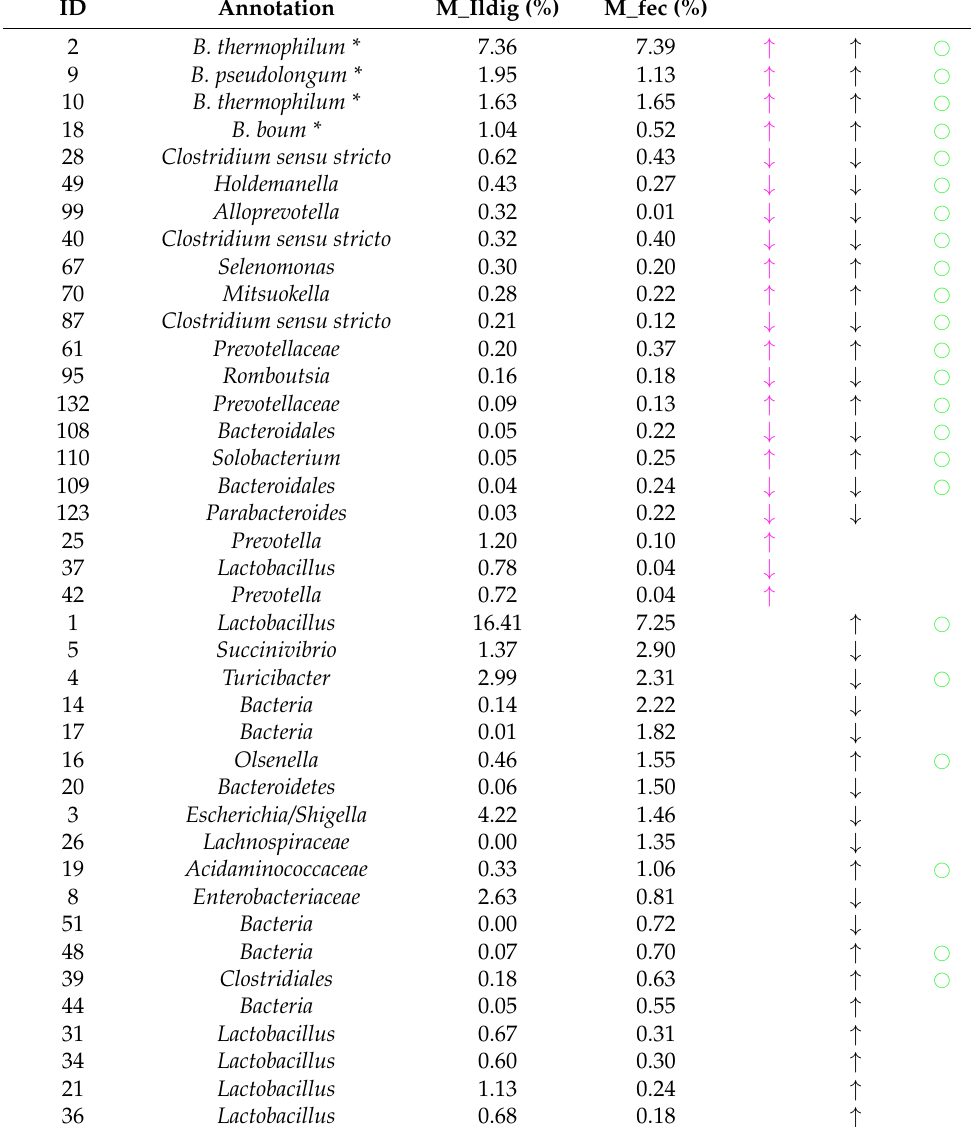
Table 2. Mean abundance of individual bacterial phylotypes that significantly changed during enzyme withdrawal. M_Ildig and M_col refer to the mean relative abundance of all ileal digesta and fecal samples, respectively. Arrows indicate significant changes (pink: ileal digesta, black: feces). Green open circles indicate significant correlations (FDR corrected Spearman’s rho < 0.05) between the two sites. *: for Bifidobacteria, the name of the closest matching species based on detailed phylogenetic analyses is